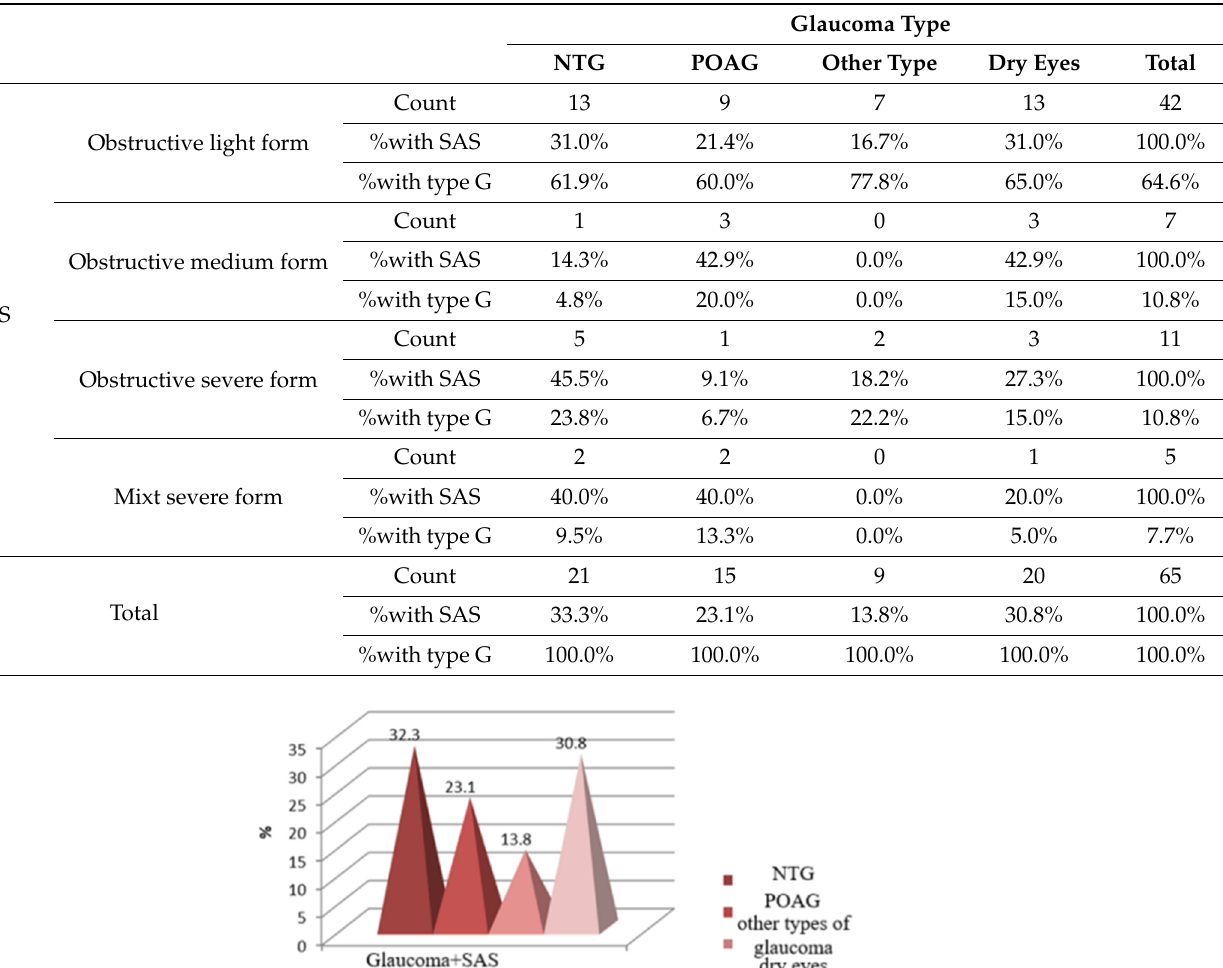
Figure 2. Percentage of conditions associated with sleep apnea syndrome.